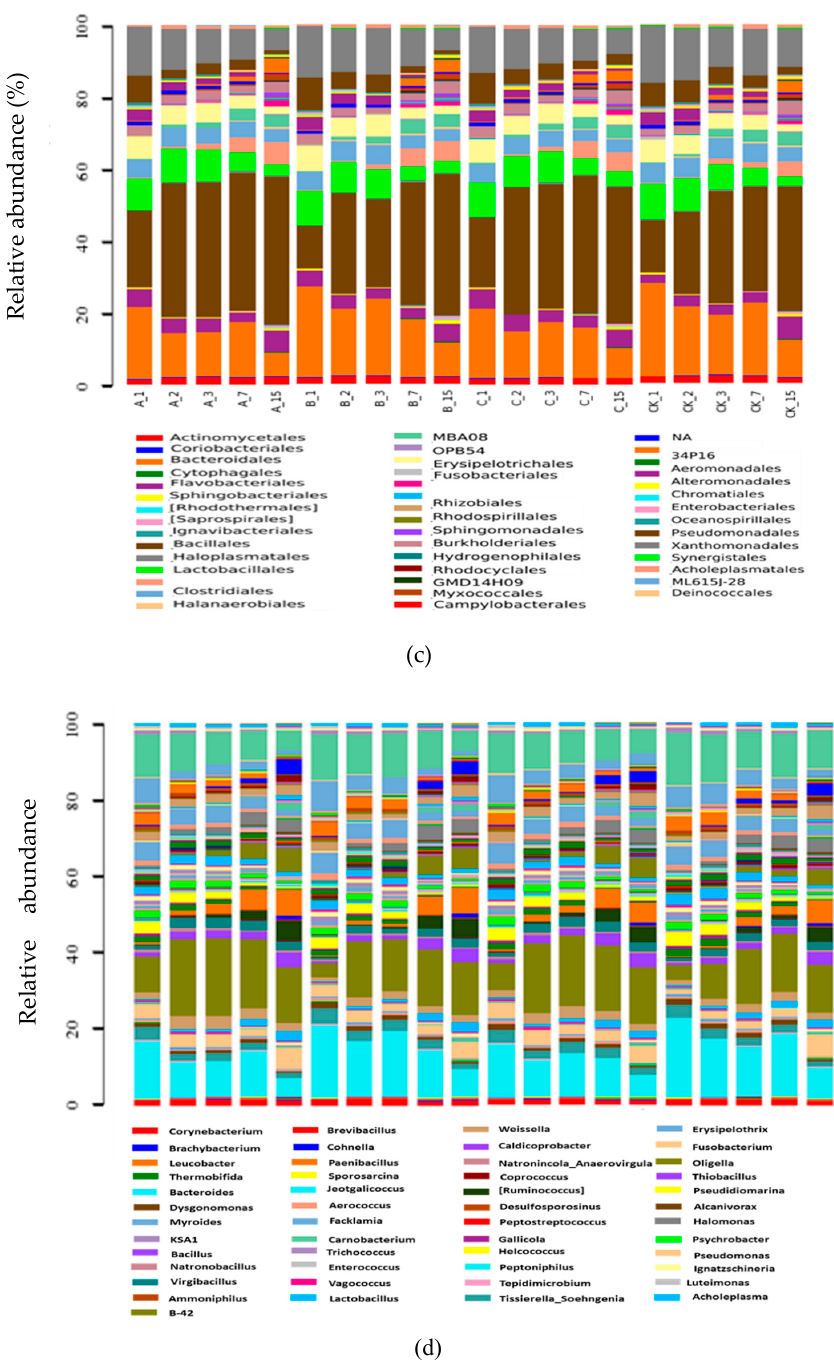
Figure 7. Variation of the basic information of the bacterial communities with different treatments; Note: ( a ) The relative abundance of the dominant bacterial taxonomic groups at the phyla level (related abundances exceed 1%) separated by 16S rDNA gene sequences; ( b ) The relative abundance of the dominant bacterial taxonomic groups at the class level (related abundances exceed 1%) separated by 16S rDNA gene sequences; ( c ) The relative abundance of the dominant bacterial taxonomic groups at the order level (related abundances exceed 1%) separated by 16S rDNA gene sequences; ( d ) The relative abundance of the dominant bacterial taxonomic groups at the genera level (related abundances exceed 1%). CK, A, B, and C were the control treatment, T mixed bacteria , T biochar , and T biochar immobilized bacteria , respectively. 1, 2, 3, 7, and 15 represent compost samples on days 1, 2, 3, 7, and 15, respectively.